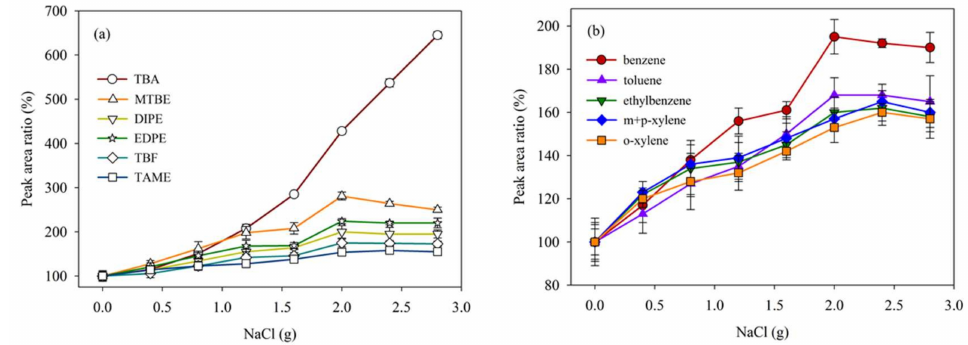
Figure 6. E ff ect of addition of NaCl on signal intensities of the twelve analytes (20 µ g / L). The peak area at no salt added is used as a reference (100%). ( a ) the peak area ratio of TBA, MTBE, DIPE, ETBE, TBF, and TAME; ( b ) the peak area ratio of benzene, toluene, ethylbenze, m + p–xylene, and